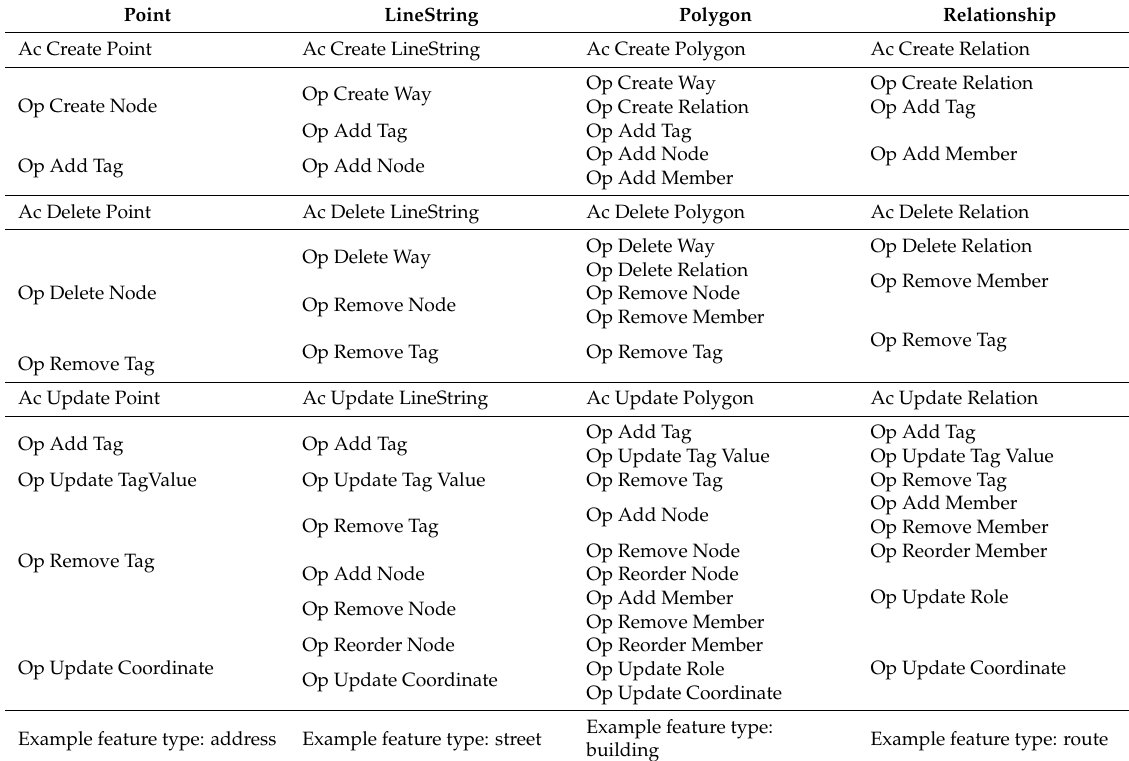
Table 6. Mapping of operations to